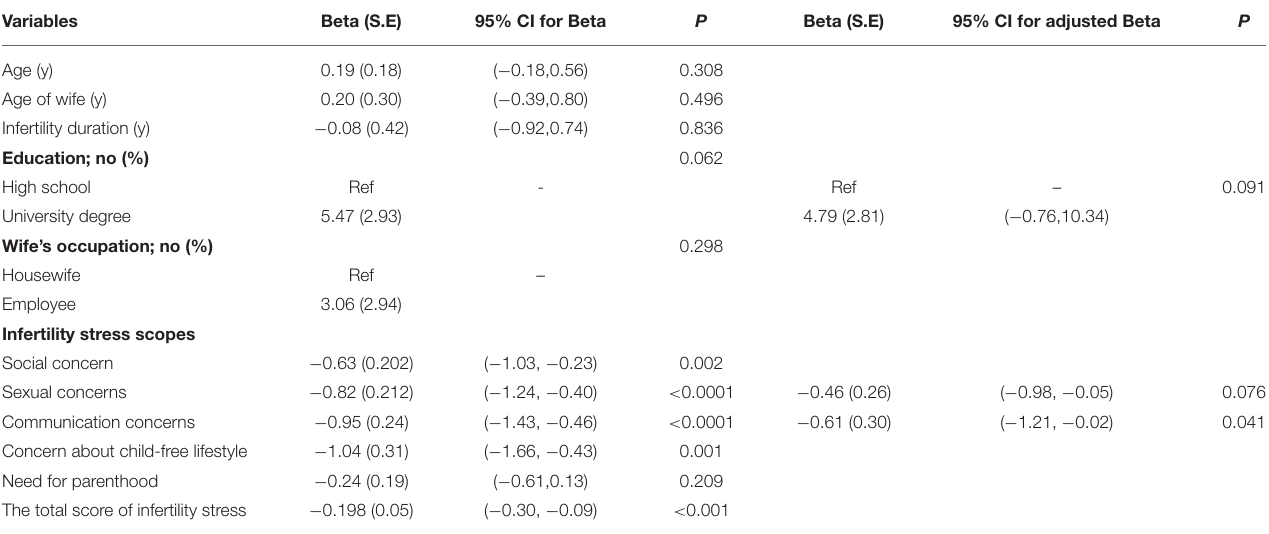
TABLE 5 | Results of univariate and multiple linear regression analyses to determine parameters most predictive of sexual function in infertile men.